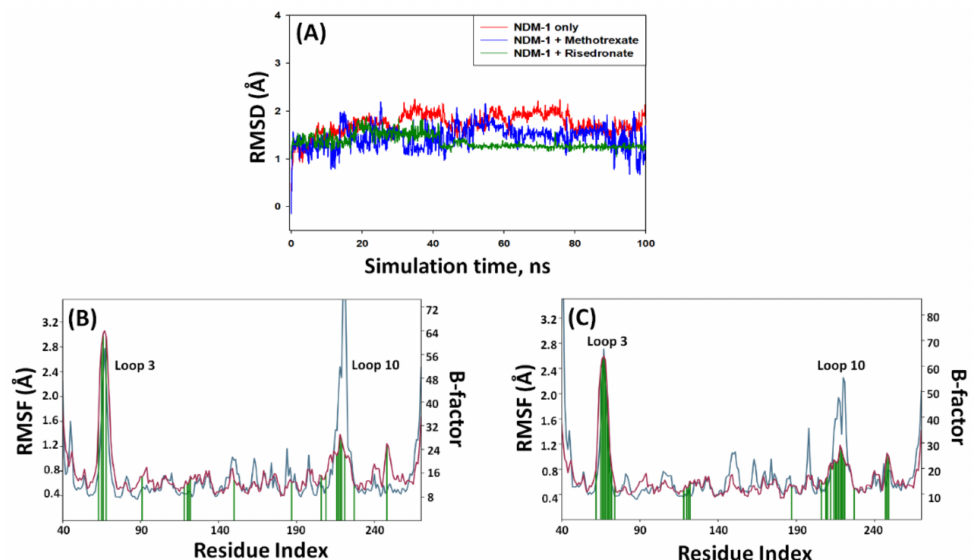
Figure 3. Molecular docking simulation of NDM-1 in complex with risedronate and methotrexate: ( A ) Root-mean-square deviation (RMSD) in the C α atoms of NDM-1 in the absence and presence of risedronate and methotrexate. Root-mean-square fluctuation (RMSF) in the side chains of NDM-1 complexed with ( B ) risedronate and ( C )